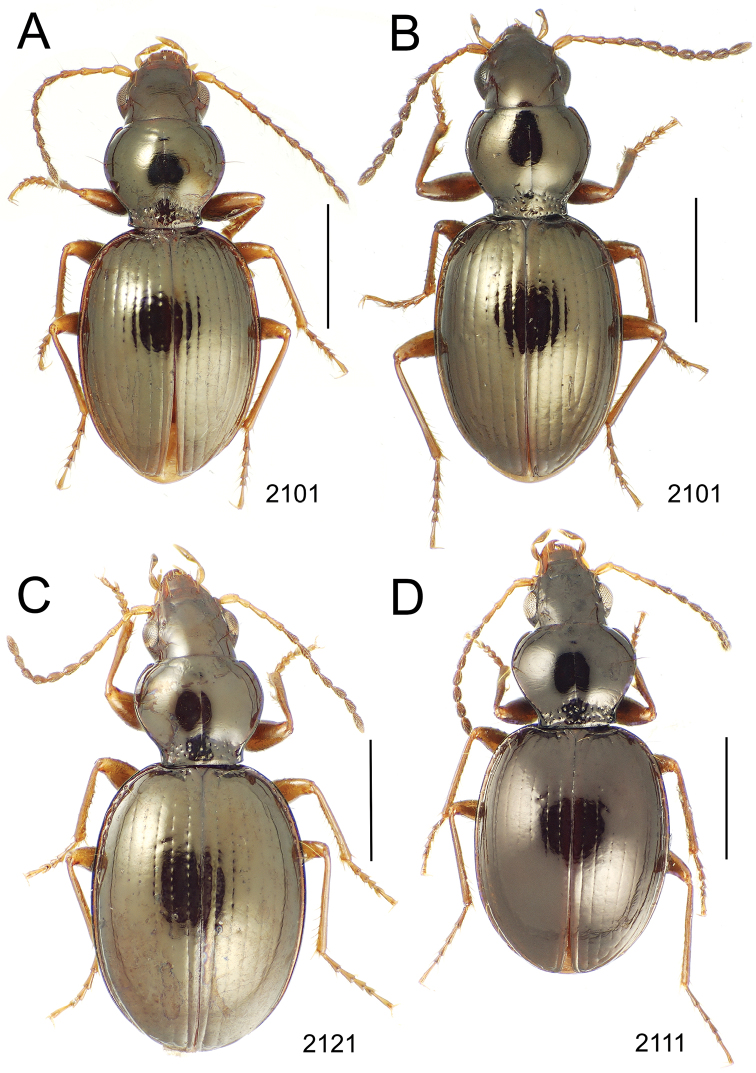
Mecyclothorax spp., dorsal view; scale bars 1.0 mm; setal formula (see Fig. 10) at lower right of each figure A
Mecyclothorax rahimata holotype male B
Mecyclothorax popotioaoa holotype male, Mont Tohiea, Moorea C
Mecyclothorax anaana paratype male (CUIC) D
Mecyclothorax hemisphaericus